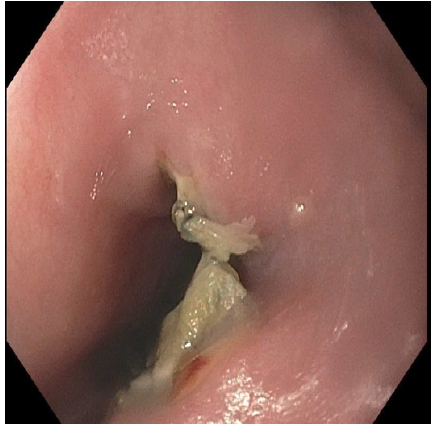
Figure 5. Endoscopy four days following the button battery ingestion. It demonstrates a single, non-bleeding erosion and necrotic tissue in the middle esophagus.